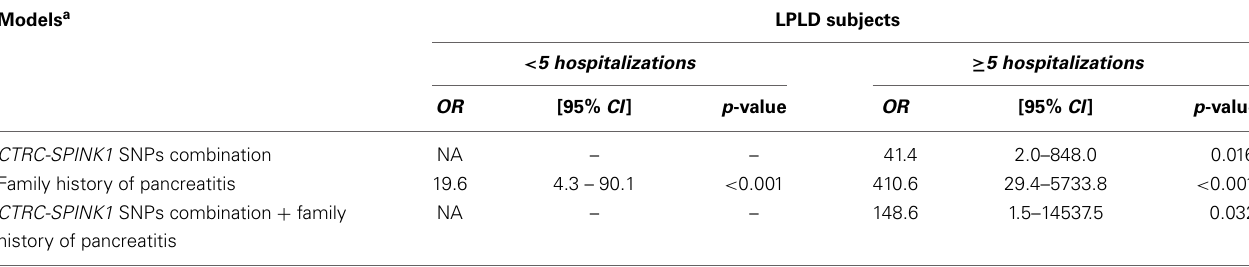
Table 3 | Association of CTRC and SPINK1 SNPs Combination and Family History with Recurrence ( ≥ 5) of Hospitalizations for Pancreatitis in Severe Hypertriglyceridemia due to